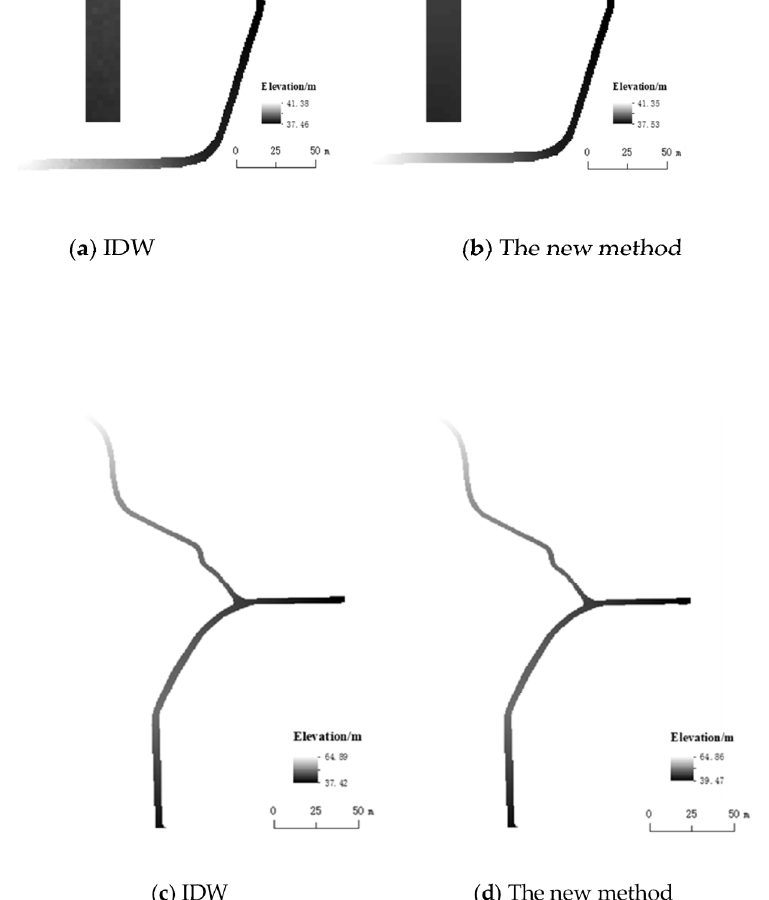
Figure 7. Road DEMs of different methods.